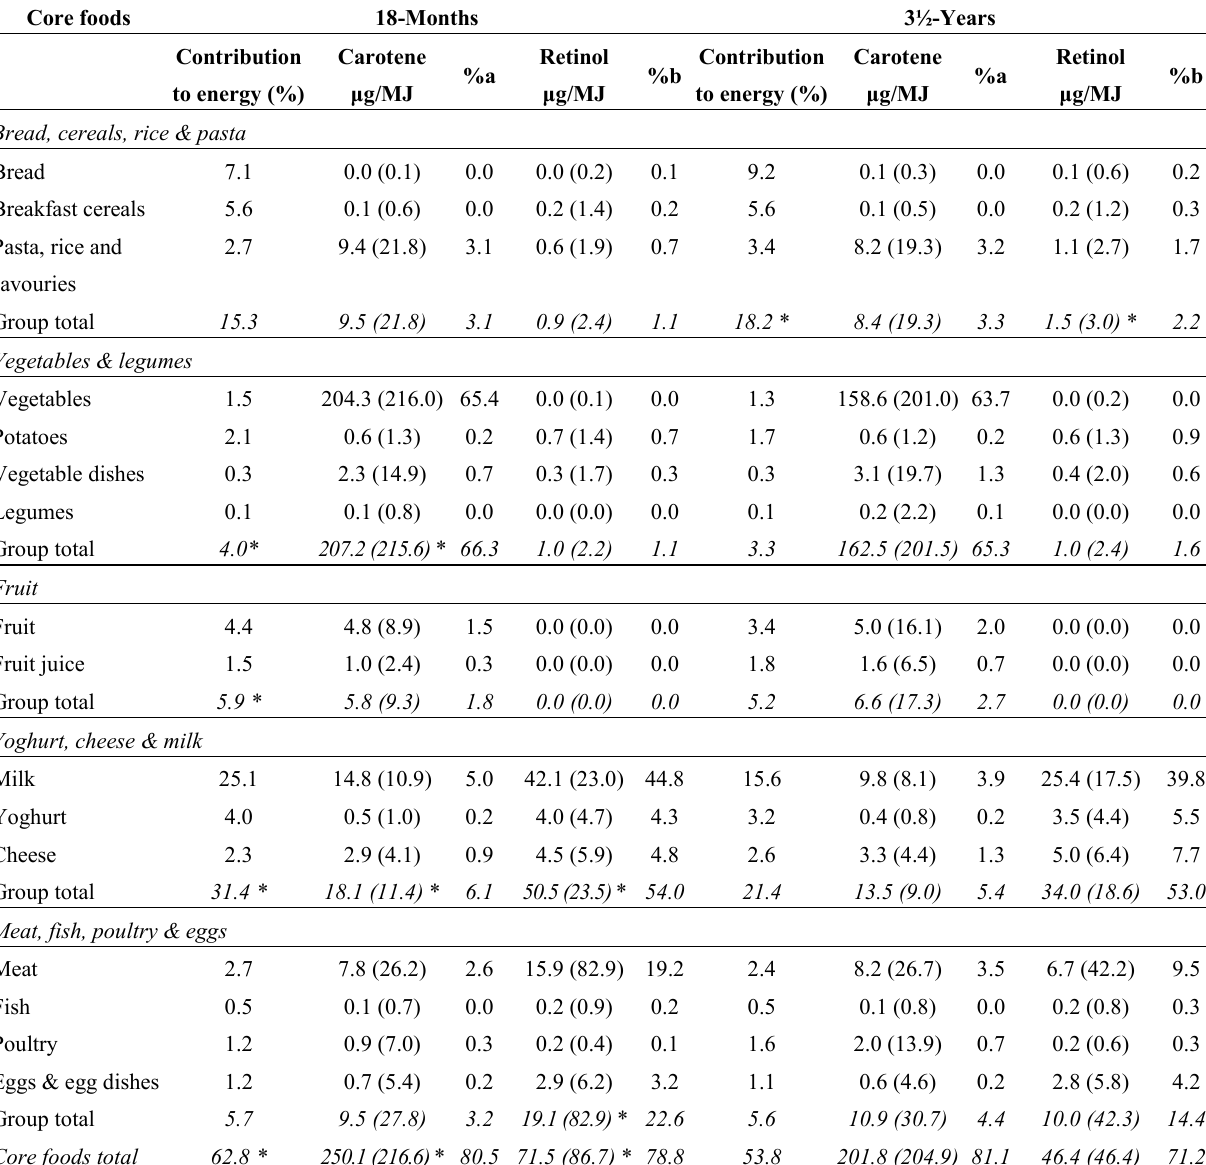
Table 2. Energy-adjusted carotene and retinol (mean (standard deviation) μg/MJ/day) and percentage contribution to energy of core food items in a cohort of children ( n = 755) at 18-months and 3½-years. Food group intakes of carotene and retinol compared between 18 months and 3½-years by paired t